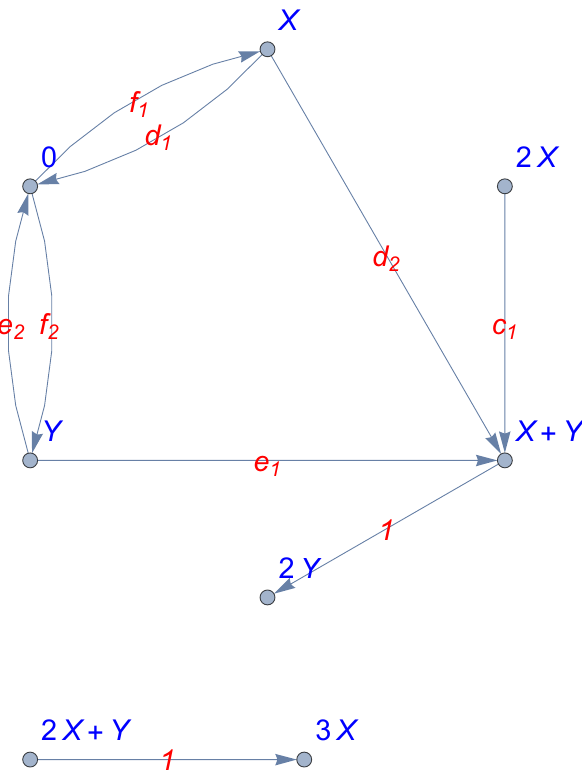
Figure 8. The reaction inducing the system